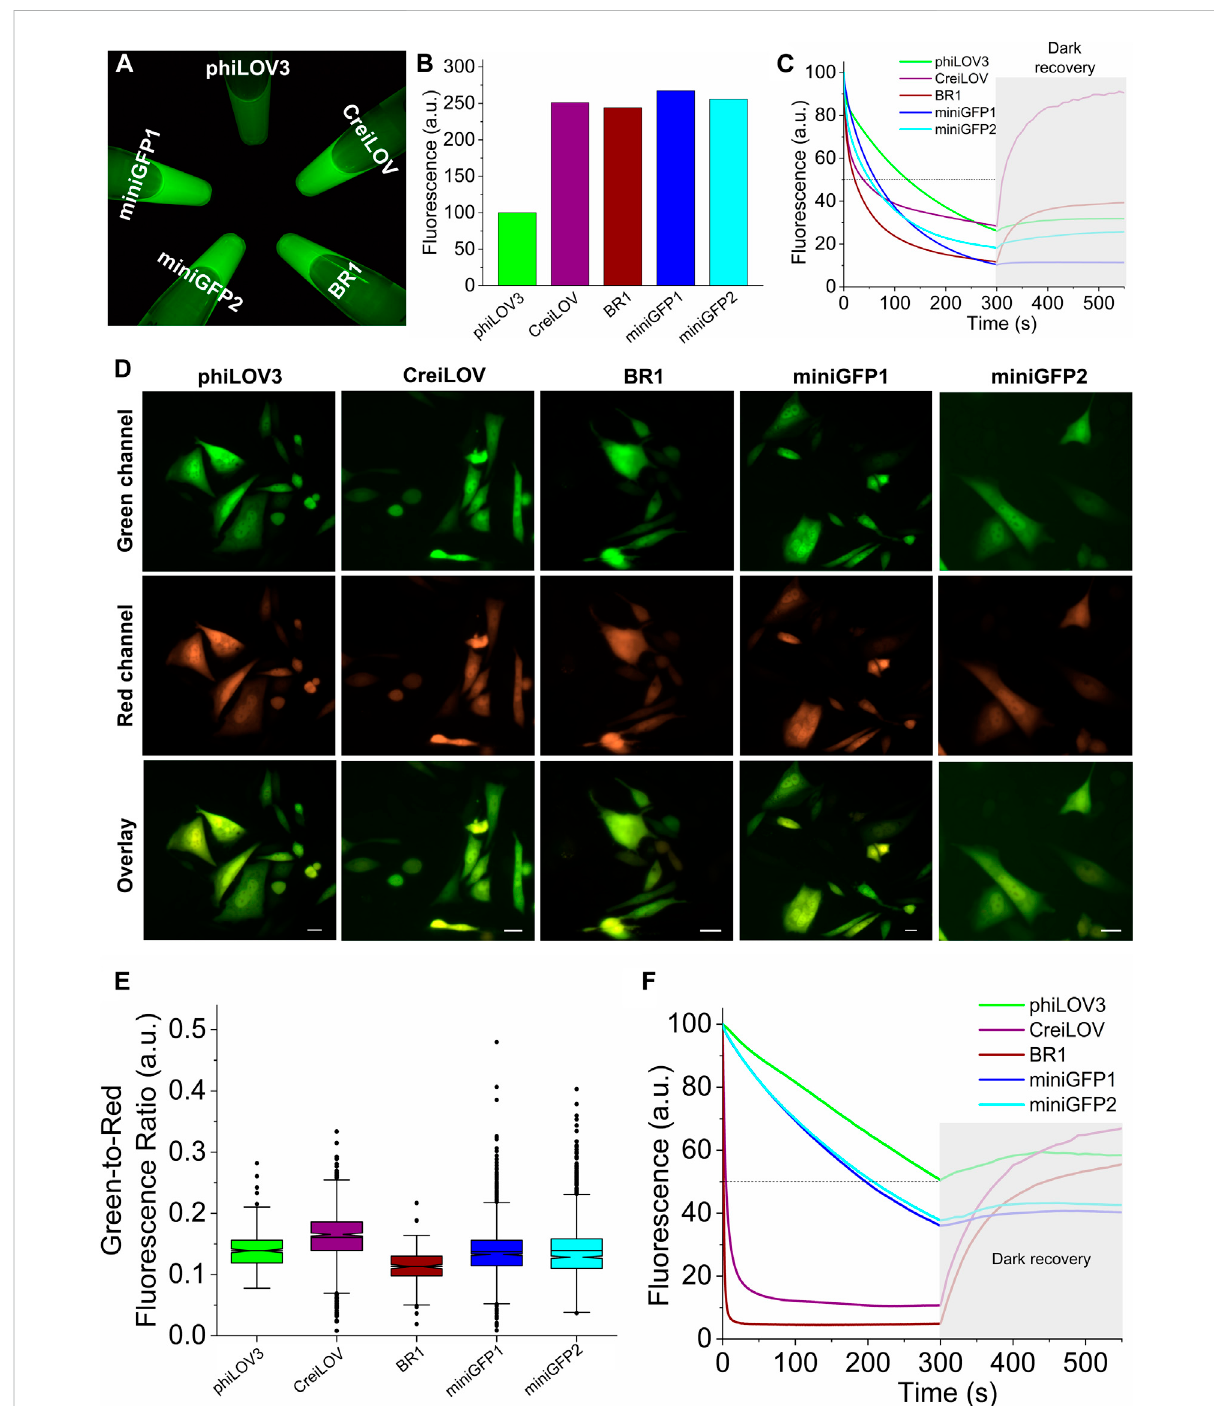
FIGURE 3 Biochemical characterization of miniGFPs in comparison to phiLOV3, CreiLOV, and BR1. (A) Green fl uorescence image of crude extract from E.coli cells expressing selected proteins. (B) Quanti fi cation of fl uorescence intensity of the samples shown in (A) . (C) Photobleaching and dark recovery curves measured on bacterial streaks expressing the selected proteins ( n = 1 streak for each protein; shaded area correspond to dark recovery phase). (D) Representative images of CHO cells expressing the selected proteins in green and red channels. Scale bar, 20 µm. (E) Green-to-red fl uorescence ratios for phiLOV3, CreiLOV, BR1, miniGFP1, and miniGFP2 expressed in CHO cells ( n = 370, 905, 211, 2,220, 1,501 cells fromtwoindependenttransfectionseach,respectively).Boxplotswithnotchesareusedfordatavisualization(narrowpartofnotch,median;topand bottomofthenotch,95%con fi denceintervalforthemedian;topandbottomhorizontallines,25%and75%percentilesforthedata;whiskersextend 1.5 × the interquartile range from the 25th and 75th percentiles; horizontal line, mean; dots, outliers). (F) Photobleaching and dark recovery curves measured on live CHO cells expressing phiLOV3, CreiLOV, BR1, miniGFP1, and miniGFP2 proteins ( n = 114, 52, 74, 98, and 62 cells from two independent transfection each,